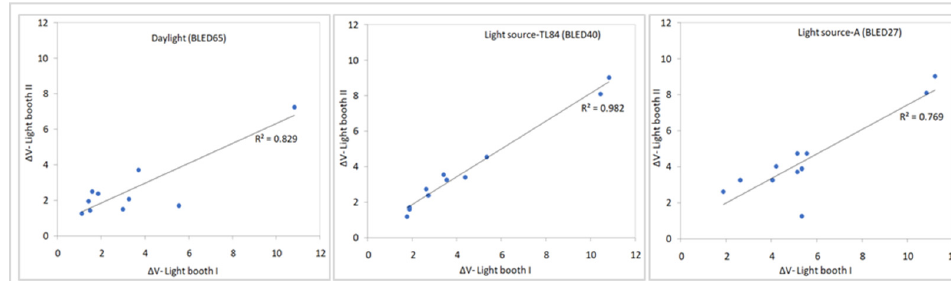
Figure 8. Visual color difference under different light sources between two booths. In the figure, BLED65, BLED40, and BLED27 represent the light sources with nominal CCT 6500 K, 4000 K, and 2700 K respectively for light booth I; and Daylight (Simulator D65), TL84 (Tri-band fluorescent tube), and A (Tungsten lamp) represent the light sources with nominal CCT 6500 K, 4000 K, and 2700 K respectively for light booth II.